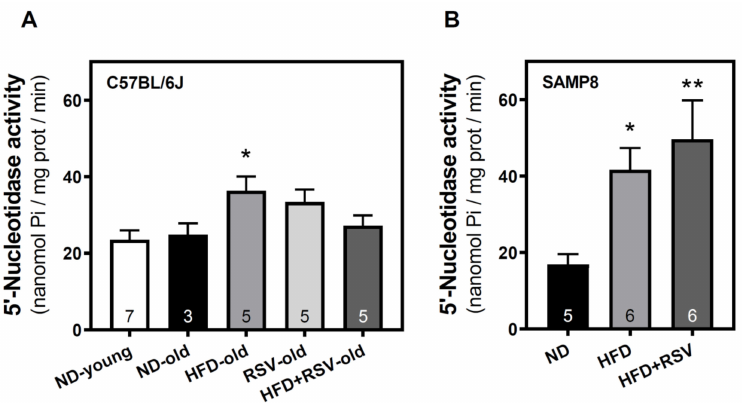
Figure 1. 5 (cid:48) -Nucleotidase activity in the cerebral cortex. The plasma membrane fraction was used in order to assess the activity of 5 (cid:48) -nucleotidase in the cerebral cortex of C57BL/6J ( A ) and SAMP8 ( B ) mice. Enzymatic activity was measured as described in Methods. Data are the mean ± SEM of three-seven different samples (indicated within the bars). * p < 0.05 and ** p < 0.01 significantly different from ND-old experimental group in panel A or from ND cohort in Panel B according to one-way